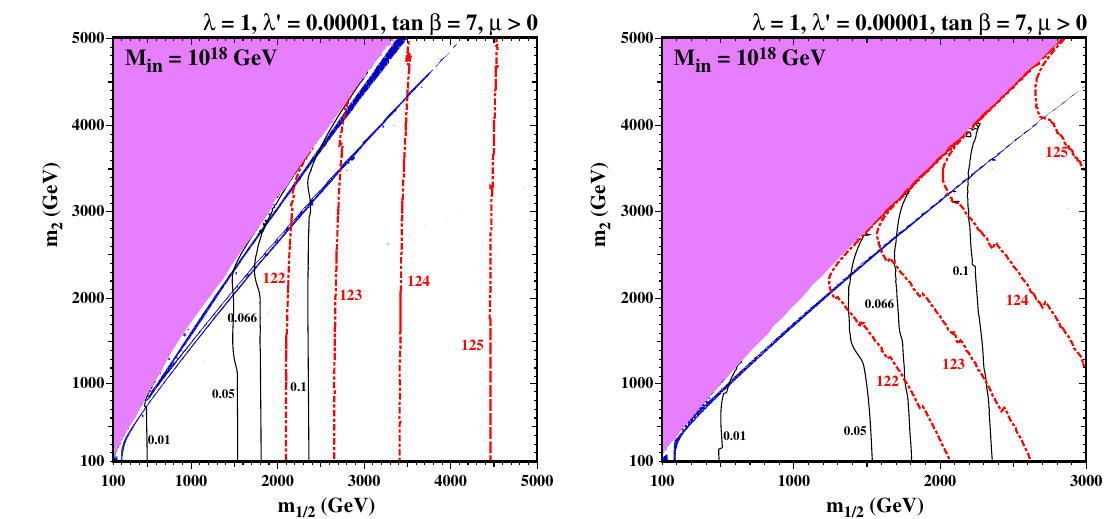
are zero, so that A t = m 2 , A b = 0, A λ = m 2 , A λ (cid:2) = 0, B H = m 2 , and Fig. 7 Examples of ( m 1 / 2 , m 2 ) planes for M in = 10 18 when only H B (cid:3) = 0. In both panels tan β = 7, λ = 1 and λ (cid:2) = 10 − 5 . The shadings is twisted. In the left panel , all trilinear and bilinear terms are zero. The modular weights are α t = 1, α b = 0, α λ = 1, α λ (cid:2) = 0, β H = 1 and and contour colors are the same as in Fig. 1. The width of the relic β (cid:3) = 0, corresponding to A = B = 0. In the right panel , all weights density region ( shaded blue ) has been enhanced for better 0 0